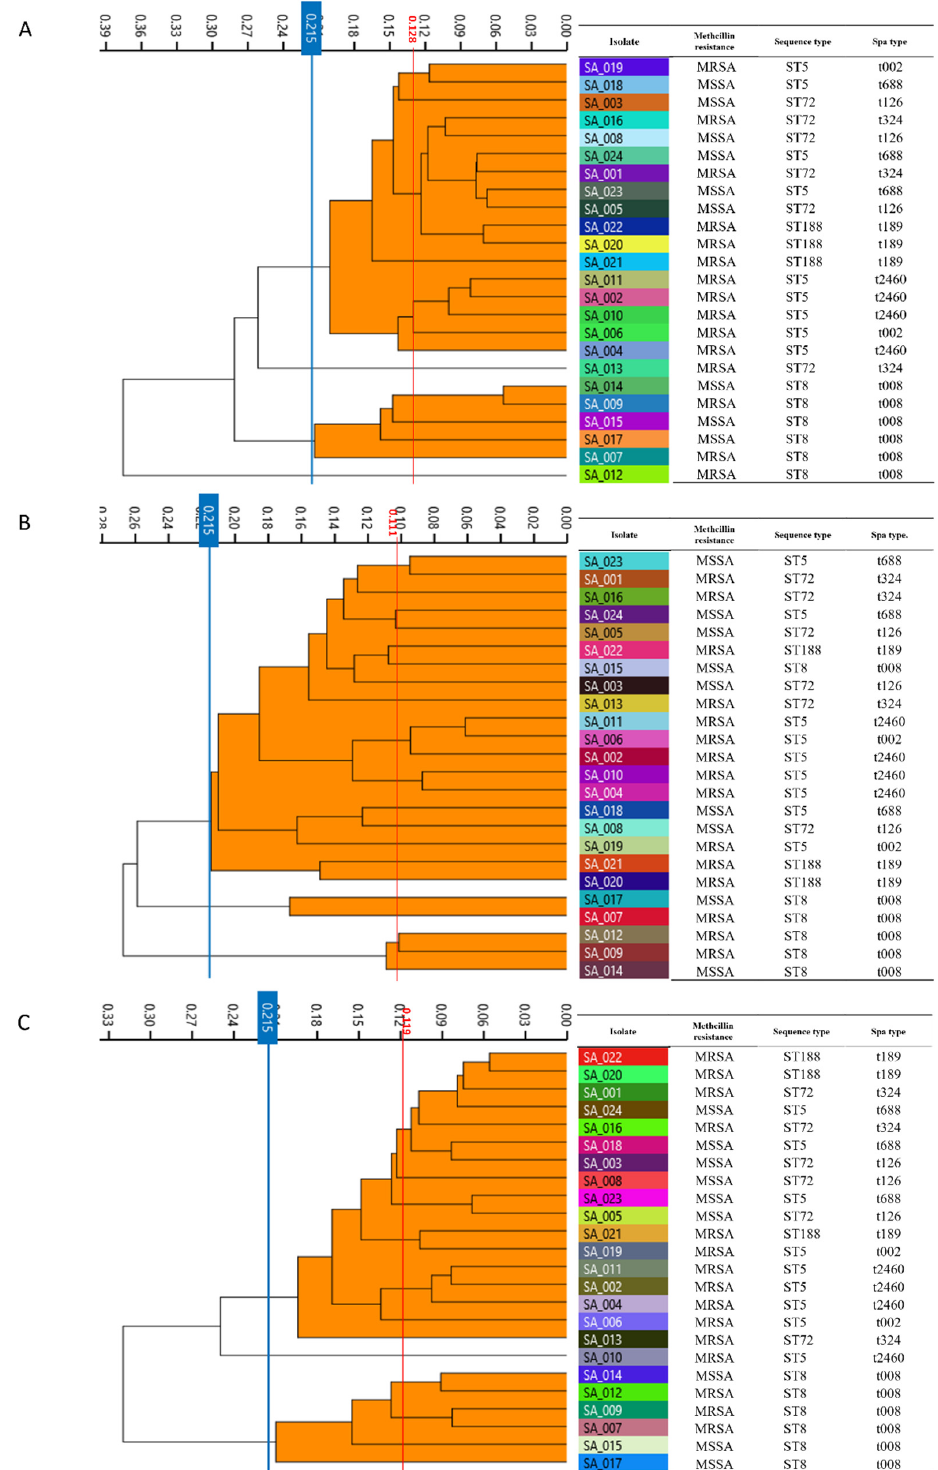
Figure 1. Dendrograms of 24 S. aureus isolates based on the IRBT ® spectra on three media at cut-off of 0.215 with bacterial molecular profiles. The cut-off value automatically generated by the OPUS 7.5 software was indicated with red vertical line. ( A ) 24 spectra of S. aureus isolates on BAP medium by averaging three technical replicates, ( B ) 24 spectra of S. aureus isolates on MHA medium by averaging three technical replicates, ( C ) 24 spectra of S. aureus isolates on TSA medium by averaging three technical